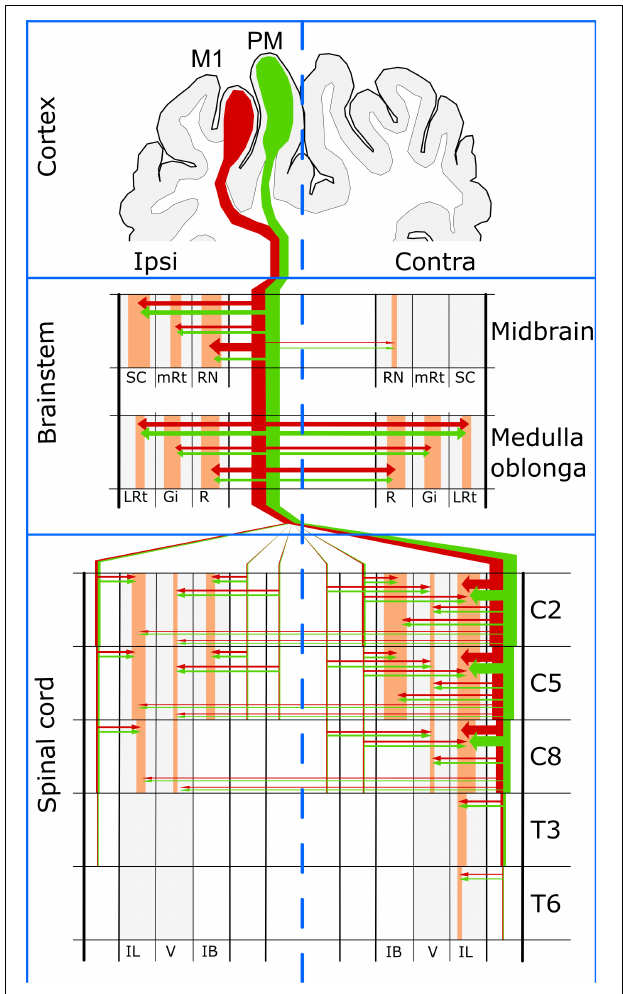
FIGURE 9 | Summary of the cortical motor system in the domestic pig. SC, superior colliculus; RN, red nucleus; mRt, mesencephalic reticular formation; LRt, lateral reticular formation; Gi, gigantocellular reticular nucleus; R, raphe nuclei; IL, intermediolateral gray matter region; V, ventral gray matter region; IB, internal basilar